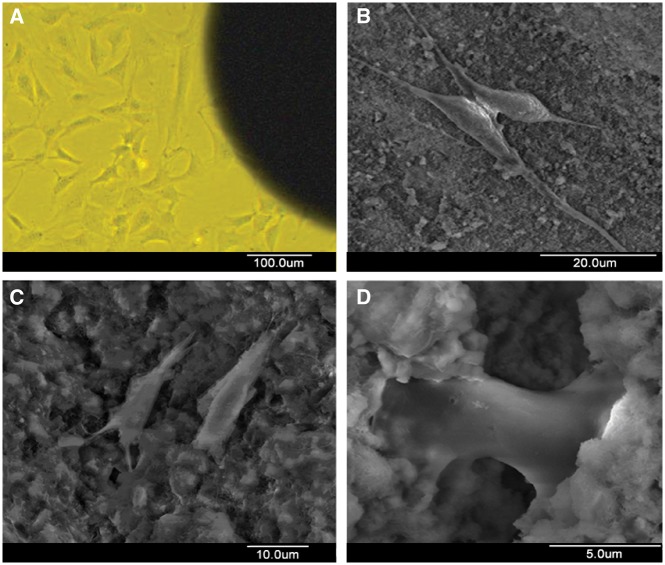
Inverted microscope and SEM images of cells on three types of material: (A, B) β-TCP/CPC, (C) α-TCP/CPC, (D) chitosan microsphere/CPC